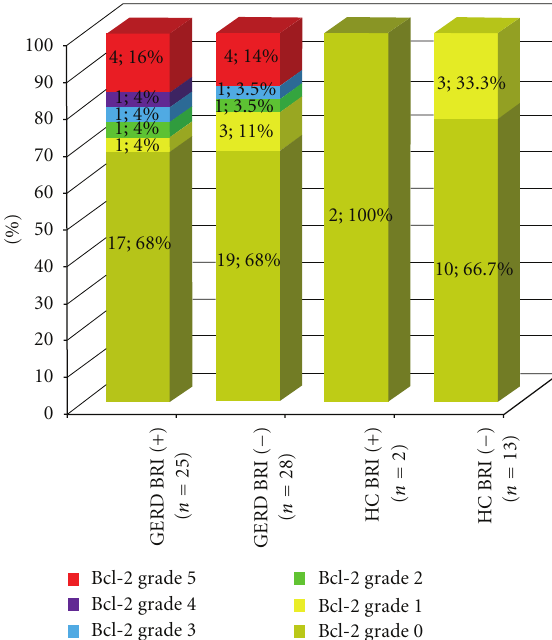
Figure 2: Bcl-2 expression in gastric mucosa in healthy controls (HC) and GERD patients, in relation to BRI status. Grouped data are presented in 100% display stacked columns for each grade ( n ; %). According to the percentages of the stained epithelial cells, the immunohistological sections were scored and graded as follows: 0 = absence of staining, 1 = staining up to 5%, 2 = staining > 5%–10%, 3 = staining > 10%–25%, 4 = staining > 25%–50%, and 5 = staining >